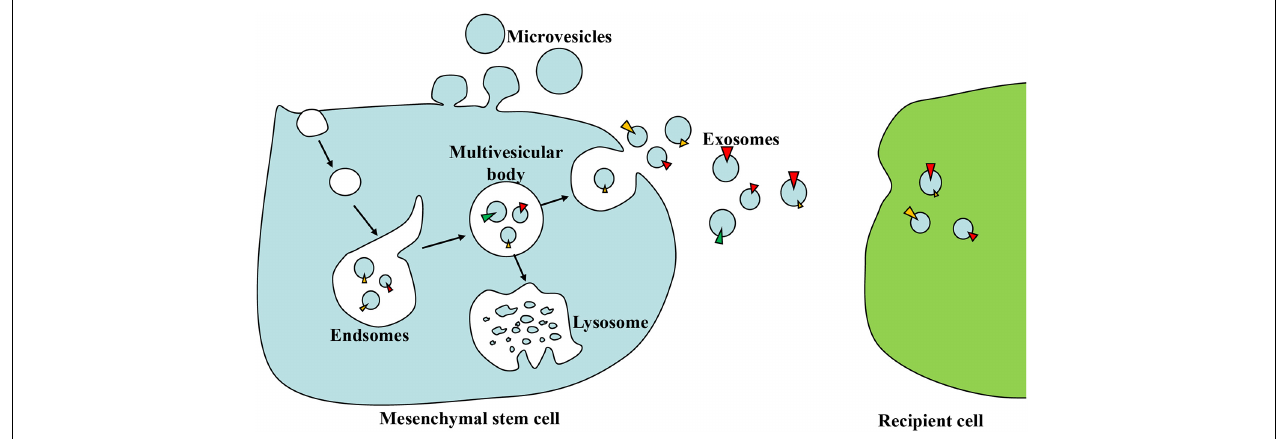
FIGURE 1 | The biogenesis and action of exosomes. Early endosomes are formed by the endocytosis of the cell membrane and then develop into multivesicular bodies (MVBs) in a budding manner. MVBs either combine with lysosomes and digest their contents or be released as exosomes through exocytosis. Exosomes can deliver lipids, proteins, and nucleic acid to recipient cells when circulating in the extracellular